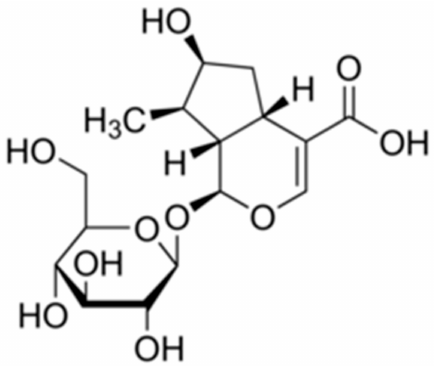
Figure 3. Molecular structure of loganic